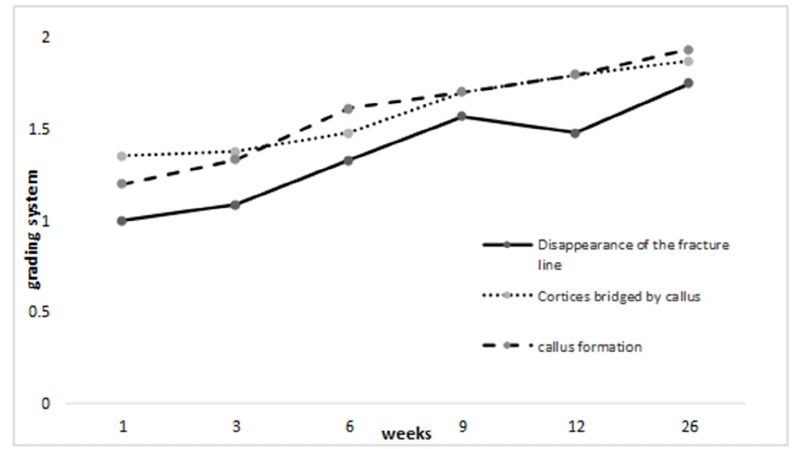
Figure 1. Timeline based on the grading system. Seven radiographs were obtained; only six are presented, as the first film was made at the time of casting.